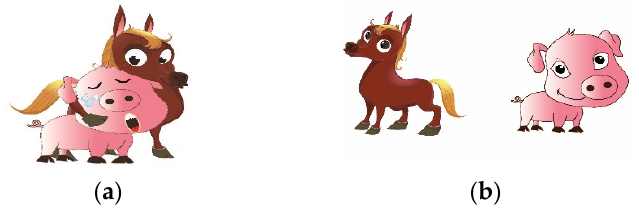
Figure 1. Pictures for experimental items. ( a ) Picture appearing with the experimental trial; ( b ) Picture appearing with the comprehension question.